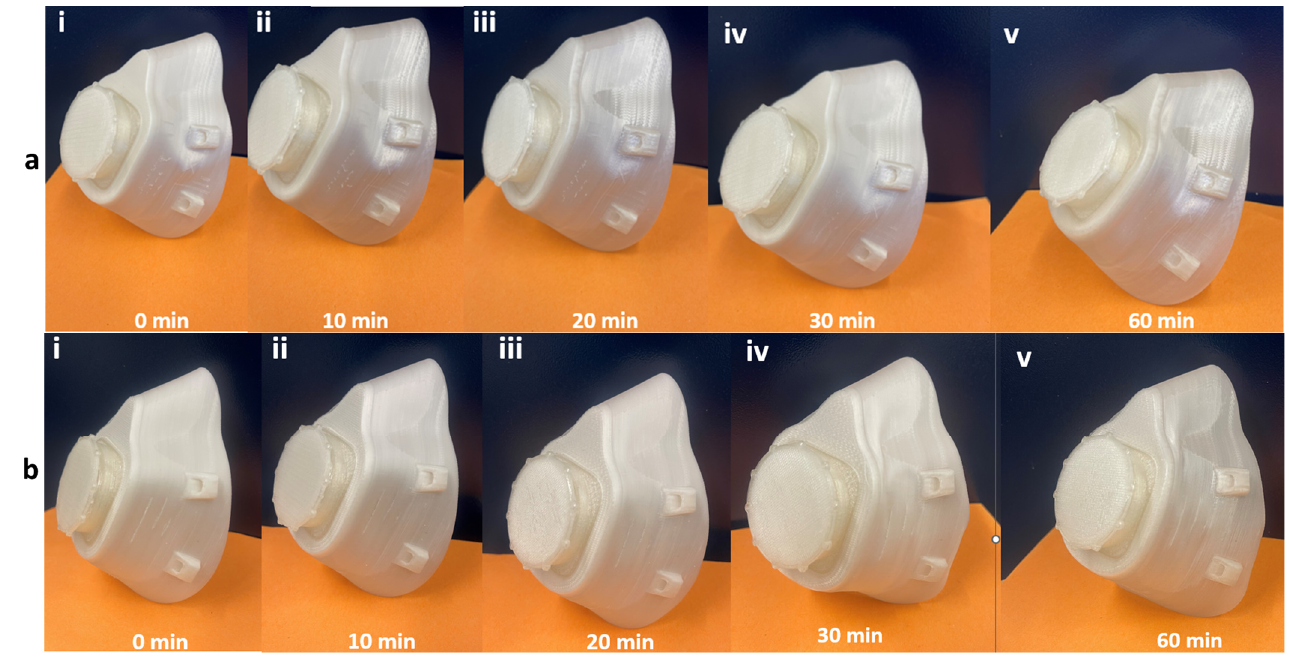
Figure 9. Self-healing process of the 3D-printed respirator mask: ( a ) from scratches ((i) 0 min, (ii) 10 min, (iii) 20 min, (iv) 30 min, (v) 60 min); ( b ) from slashes ((i) 0 min, (ii) 10 min, (iii) 20 min, (iv) 30 min, (v) 60